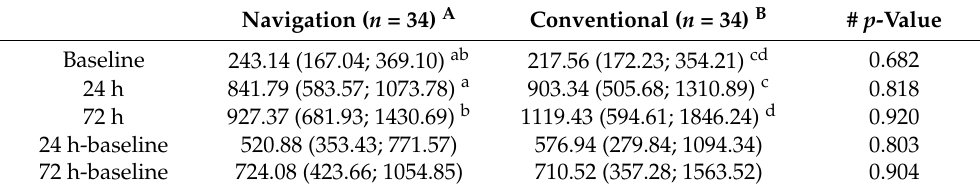
Table 3. Serum metalloproteinase-9 (MMP-9) concentrations (ng/mL) before TKA, then at 24 and 72 h after TKA.